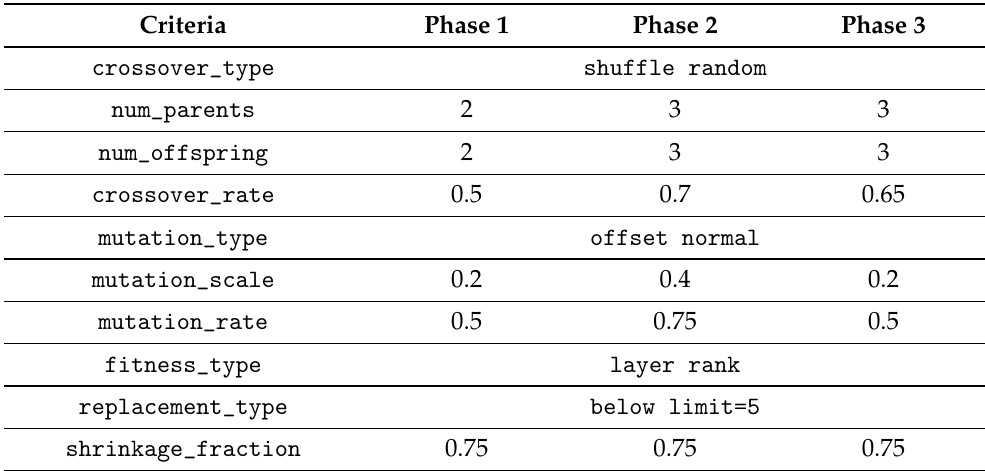
Table 3. Genetic algorithm settings used to control Dakota’s moga algorithm for each of the three phases of the optimisation.